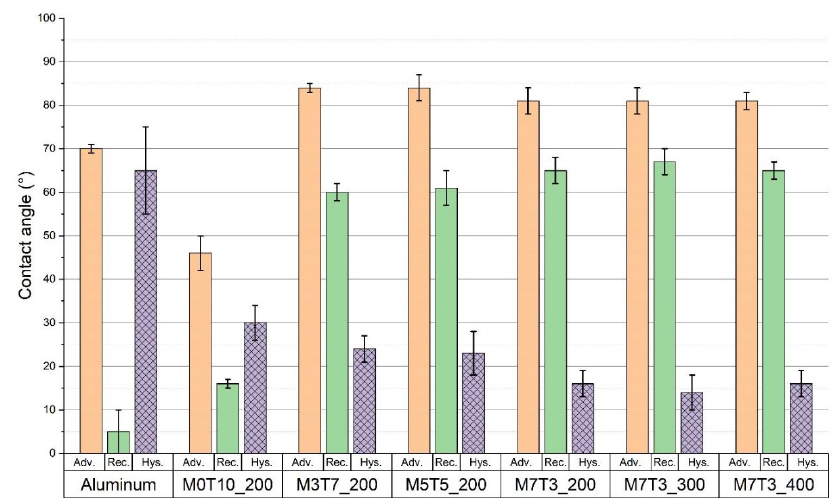
Figure 1. Contact angles of the bare aluminum and the aluminum coated with silica film with different methyl triethoxy silane (MTES)/tetraethyl orthosilicate (TEOS) ratios and different thermal annealing before condensation tests.